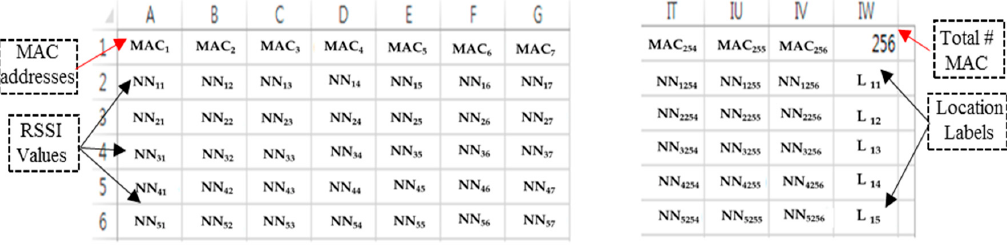
Figure 2. The comma-separated values (CSV) file format used as the input file for data augmentation.